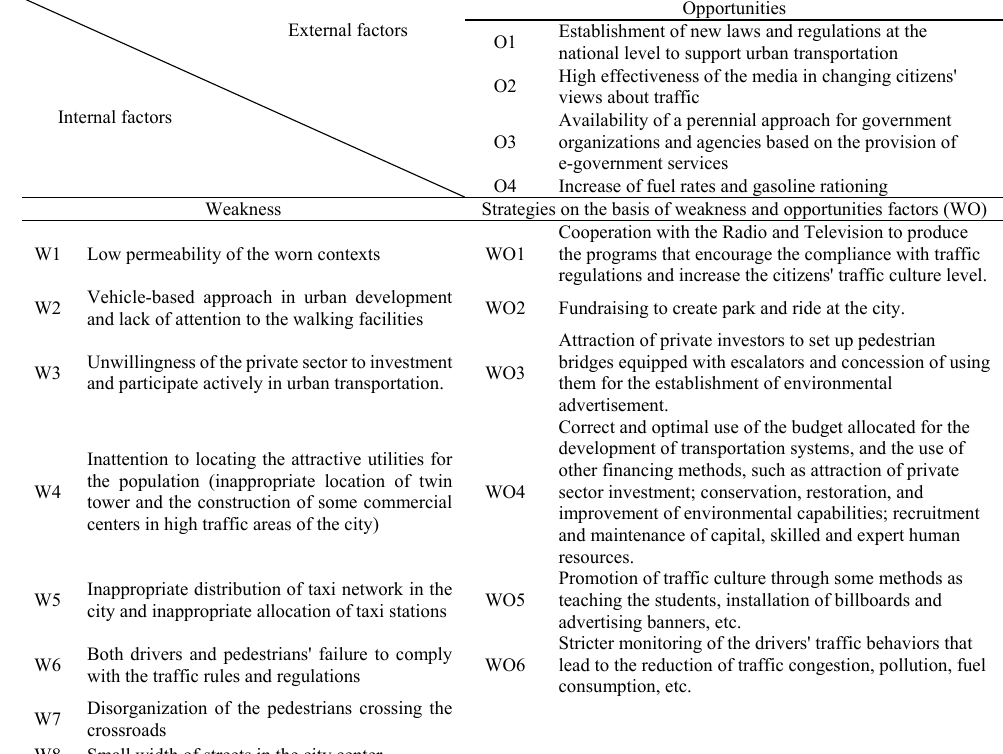
Table 5: SWOT matrix: Derivation of key strategies for urban transportation system